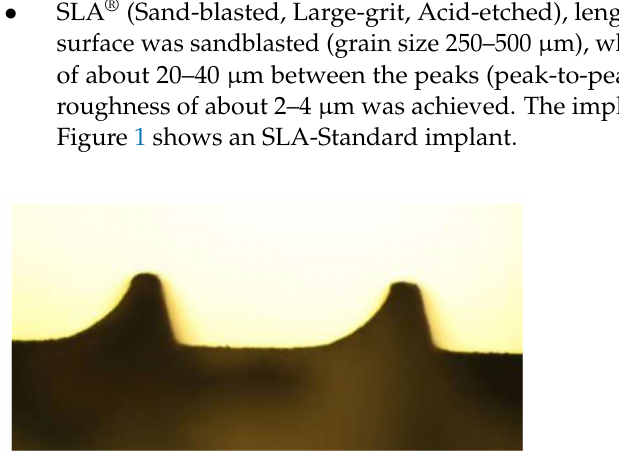
Figure 1. 2.5 × magnification with the microscope TMS-1200 TopMap µ .Lab (Institut Polytec, Wald- bronn, Germany) of the threads of the SLA-Standard implant from the Straumann Company.